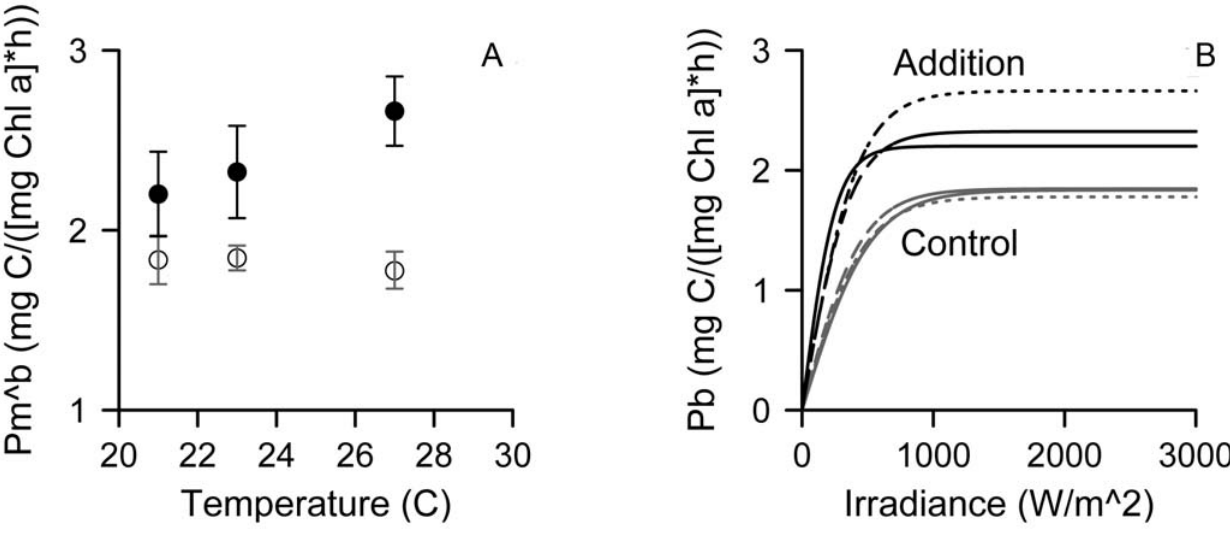
N Figure 3. Effects of temperature on primary productivity . (A) Mean ( 6 95% CI) maximum photosynthesis per unit chlorophyll biomass (P MB ) in ) and no-addition control ( # ) treatments and (B) P-I curves for nutrient addition (black lines) and no-addition control (gray lines) nutrient addition ( for ambient, + 2, and + 6 u C treatments (solid, dashed, and dotted lines, respectively).